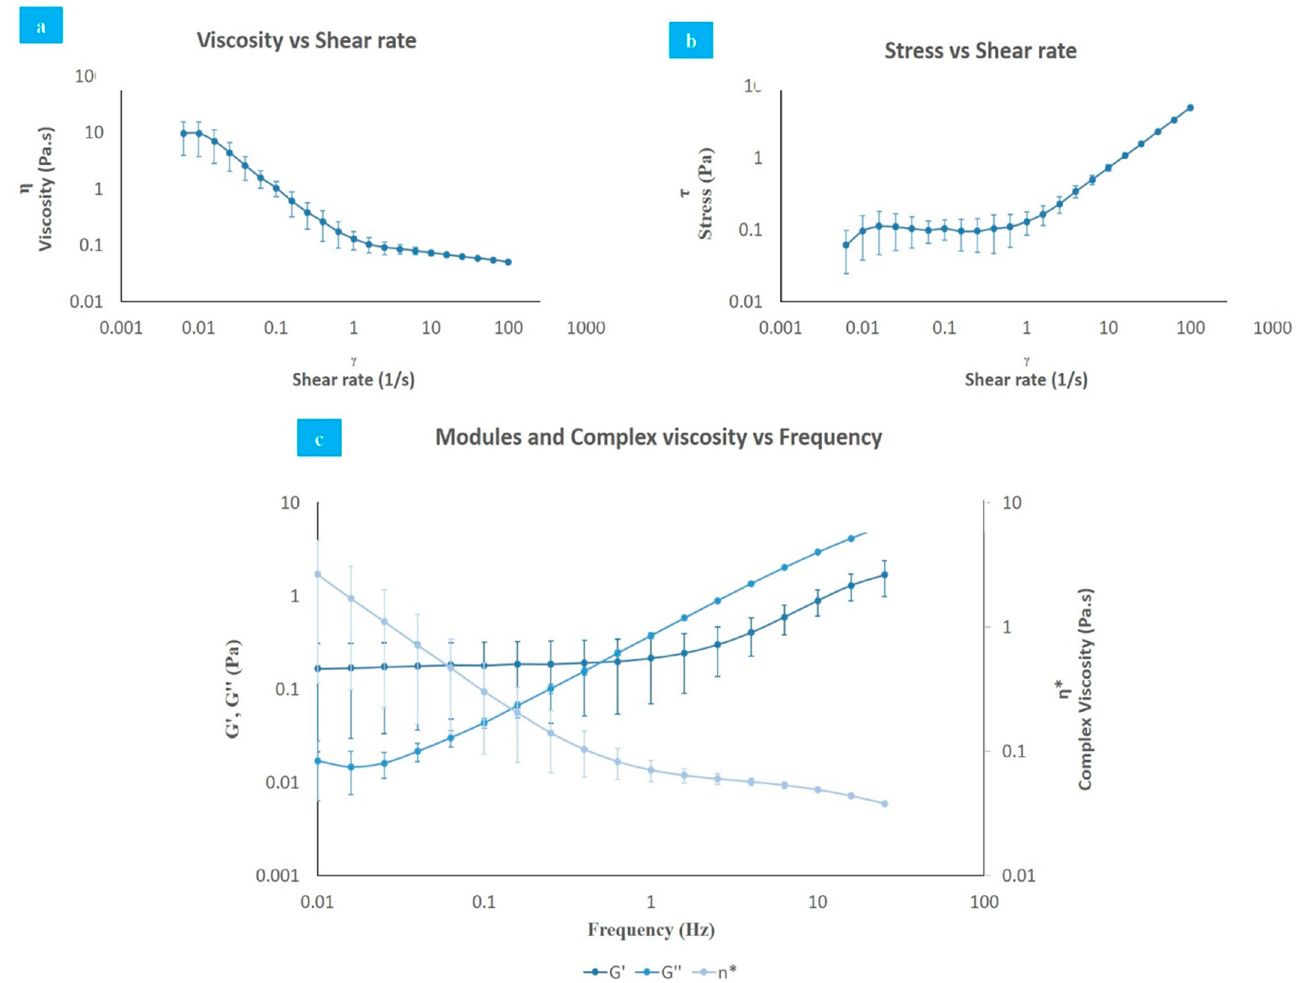
Figure 5. Rheological test. ( a ) Viscosity vs. shear rate; ( b ) shear stress vs. shear rate; ( c ) modules and complex viscosity vs. frequency (humidity, 37 °C, 0.01 – 100 Hz, 0.001 – 100 s − 1 ).